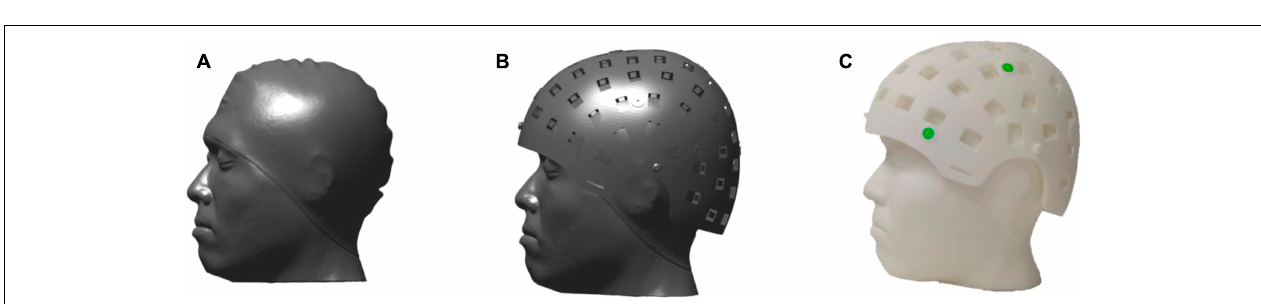
FIGURE 4 | The operation process of the co-registration method using the structured-light scanner. Transform 1: Match the helmet of the design data with the scanning data through coarse (A,B) and fine matching (C) to align sensors on the digitized points (D) . Transform 2: Match the cut face of scanning data with the MRI data to complete the co-registration. (E,F) The surface fit error of the face and the co-registration results, respectively.